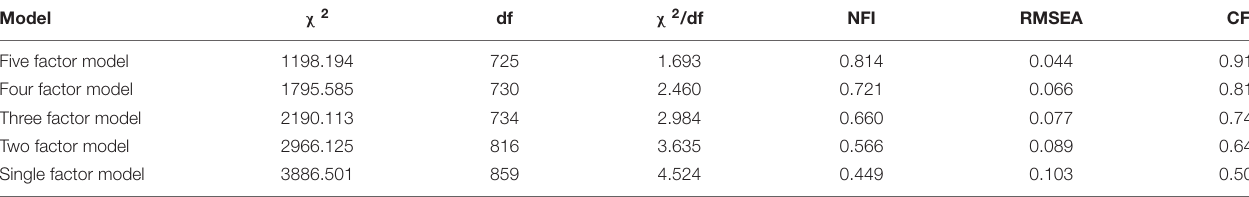
TABLE 2 | Discriminant validity analysis ( n = 333).